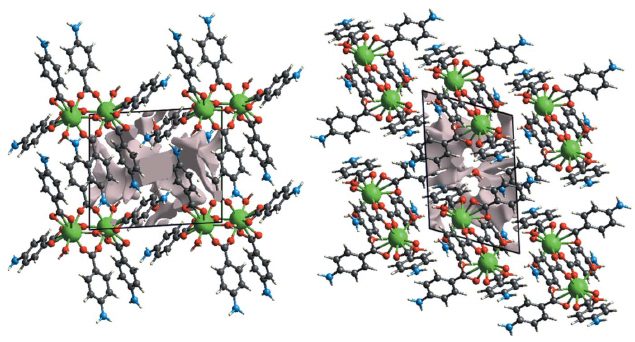
Figure 7 Graphical representation of 4ABA-Tm in ( a ) a view along the a axis and ( b ) a view along the b